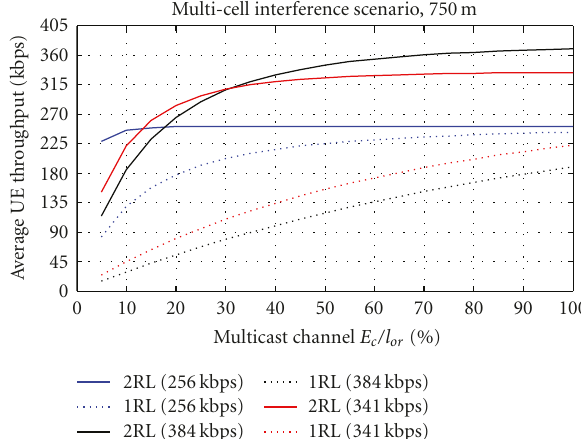
Figure 10: Average coverage (%) versus E c /I or , 1 Radio Link, k = 0 . 5.